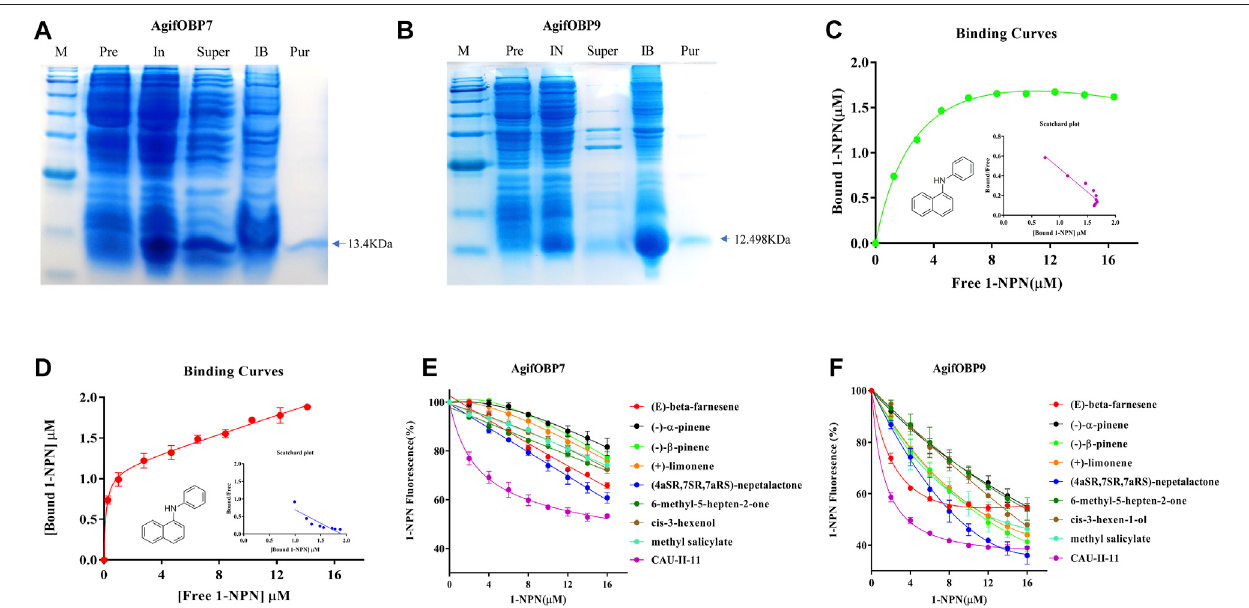
FIGURE5| ExpressionandbindingpropertiesofAgifOBP7andAgifOBP9withcandidateligands. (A) Expressionandpuri fi cationofAgifOBP7, (B) Expressionand puri fi cationofAgifOBP9.LineM:molecularweightPR1910(11 – 180 KDa)Marker,11,17,25,35,48,63,75,100,135,180 KDa;IN:InducedpET-28a(+)/AgifOBP7/9; Super: pET-28a (+)/AgifOBP7/9 Supernatant; IB: pET-28a (+)/AgifOBP7/9 Inclusion body; Pur: Puri fi ed pET-28a (+)/AgifOBP7/9 without His-tag. (C,D) Binding curves of AgifOBP7 and AgifOBP9 with N-phenyl-1-naphthylamine (1-NPN) in 50 mM Tris-HCl buffer (pH 7.4). (E,F) Competitive binding curves of AgifOBP7 and AgifOBP9 to components of aphid alarm pheromones ((E)-beta-farnesene, (-)- α -pinene, (-)- β -pinene, (+)-limonene, (E)-beta-farnesene derivative (CAU-II-11); aphid sexual pheromone (4aSR 7SR 7aRS)-nepetalactone, the volatiles of wheat green leaf (cis-3-hexen-1-ol) and aphid induced plant main volatiles (methyl salicylate, 6-methyl-5-hepten-2-one).Amixture oftherecombinant protein and N-phenyl-1-naphthylamine (1-NPN)in50 mM Tris-HCl buffer(pH7.4) at theconcentrationof2 μ M was titrated with 1 mM solutions of each competing ligand to a fi nal concentration range of 2 – 16 μ M. Fluorescence values are presented as percent of the values in the absence of competitor. Date are the means ± SD of three independent